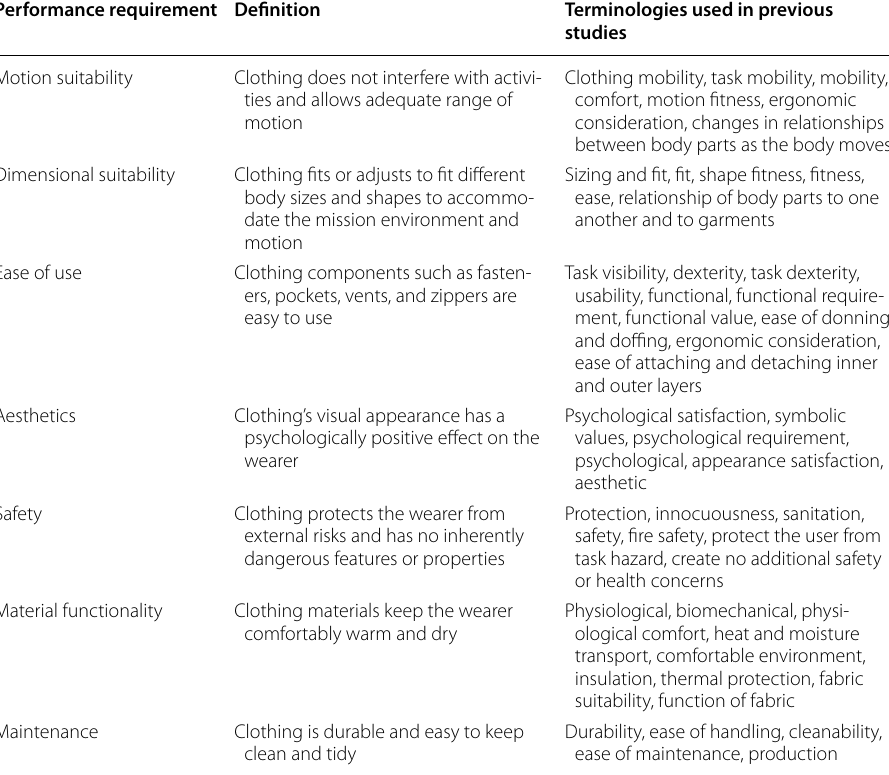
Table 1 Seven performance factor category definitions for protective clothing Performance requirement Definition Motion